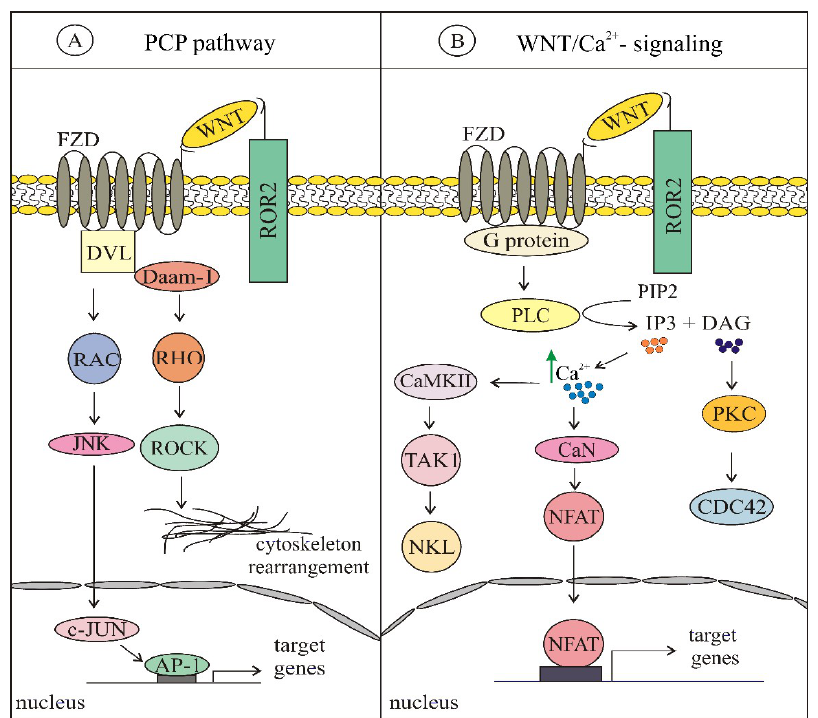
Figure 2. An overview of non-canonical WNT-signaling pathways: ( A ) WNT/planar cell polarity-signaling pathway (PCP) is initiated by WNT binding to FZD and ROR, then DVL is recruited and